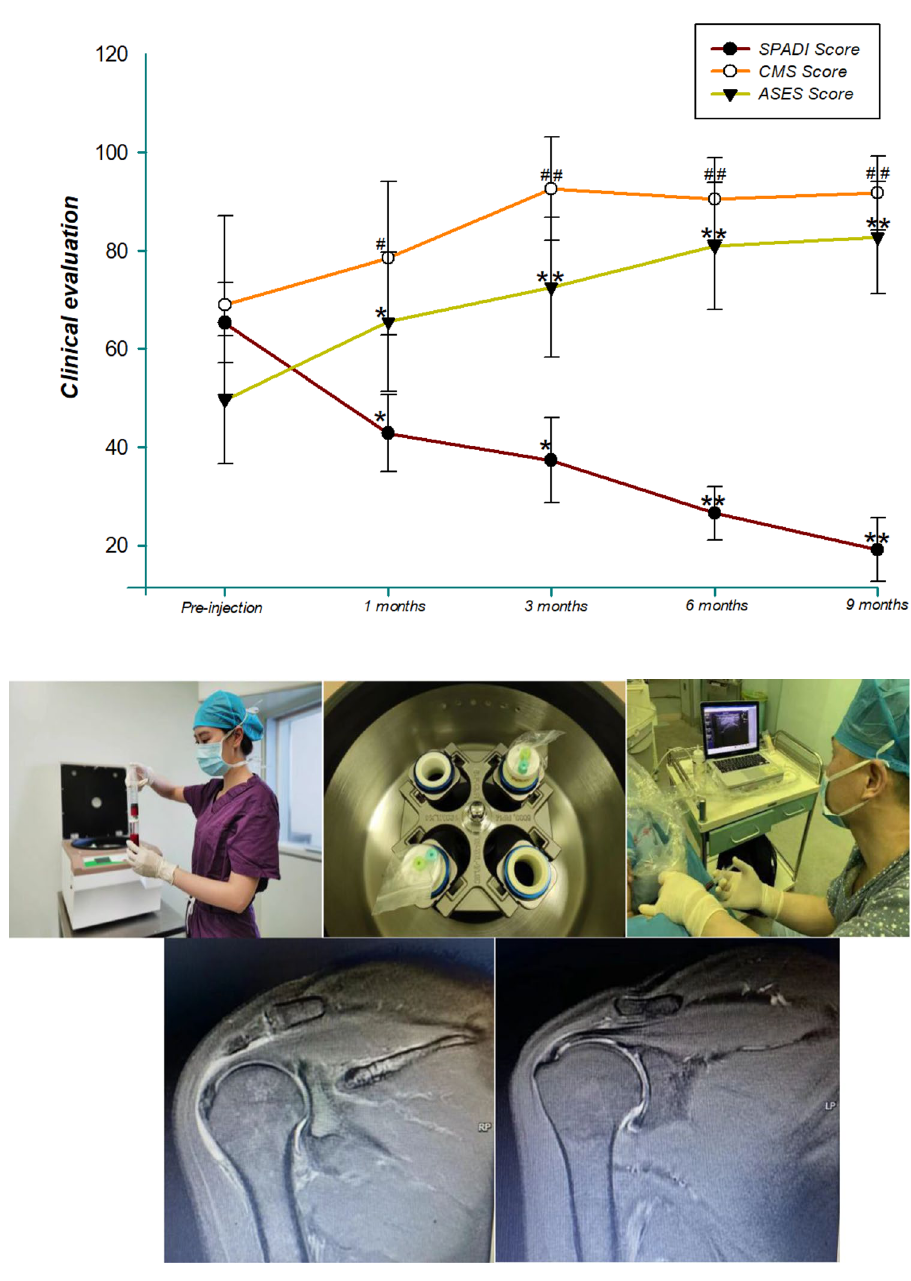
Fig. 1 SPADI, CMS and ASES Score of patients with PRP and corticosteroid injection over time (pre-injection, 1, 3, 6, 9 months). Significant dif-